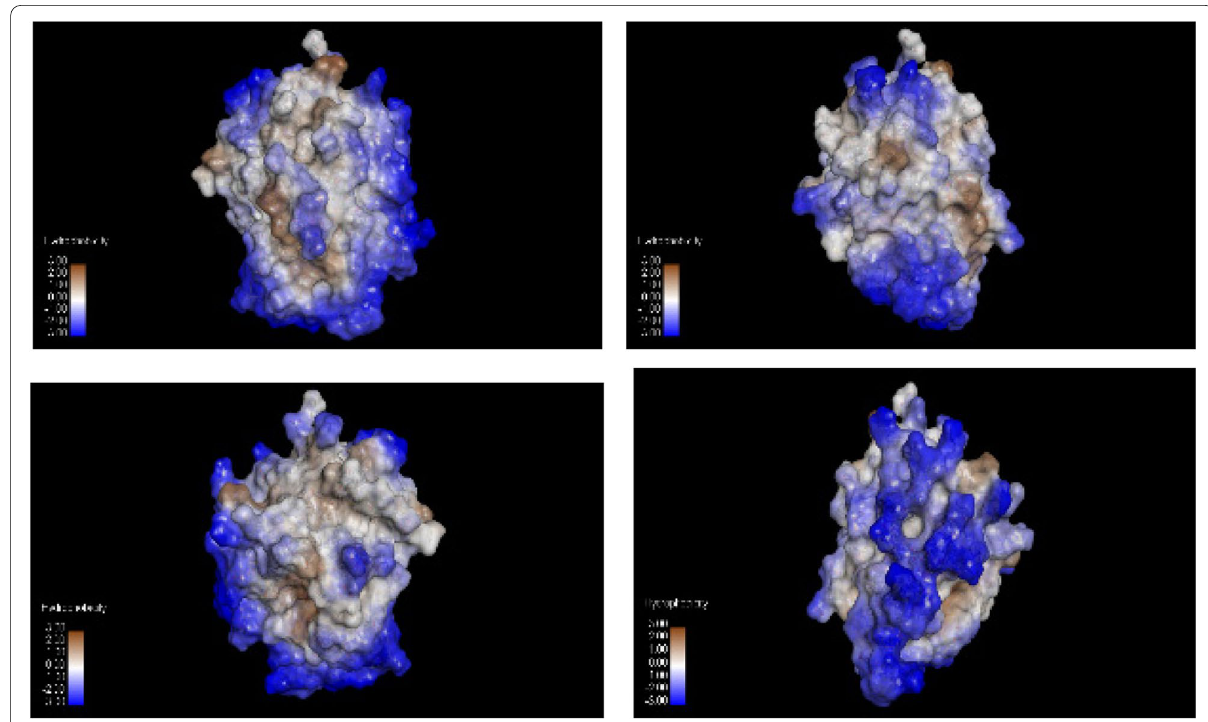
Fig. 1 Hydrophobic mapping of b30.2/SPRY domain was done by SWISS‑pdbViewer, 90° rotation difference between each image and the other was designed. According to Kyte and Doolittle [18] hydrophobicity scale, residues with a hydrophobicity of 0.7 or more are hydrophobic and those under 2.4 are hydrophilic, so the brown and light brown highlighted spots are hydrophobic patches, the blue highlighted spots are hydrophilic, − and the light spots are neutral.